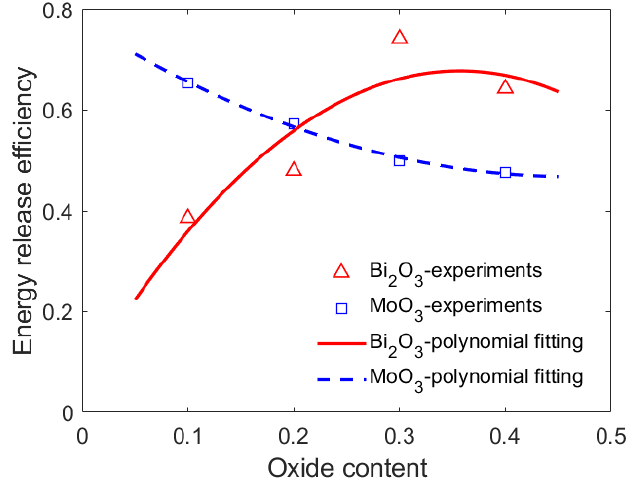
Figure 7. Energy release efficiency varying with oxide content.